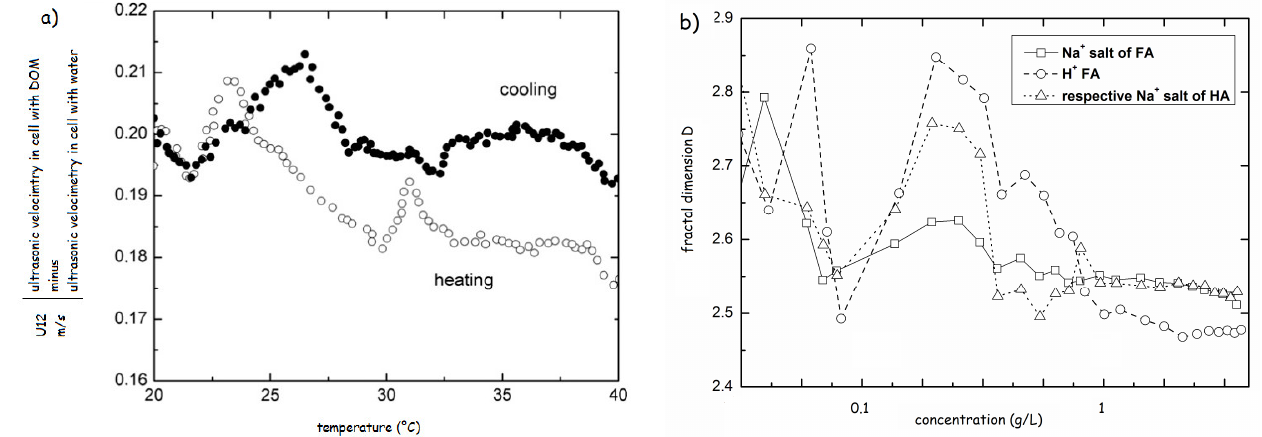
Figure 9. ( a ) Hysteresis in ultrasonic velocity of Elliot Soil sodium fulvate 0.01 g/L (based on the results of ref. [69]). ( b ) Fractal dimensions of Na + salts of Elliot soil HA and FA and H + form of Elliot soil FA (based on the results of ref. [70]).